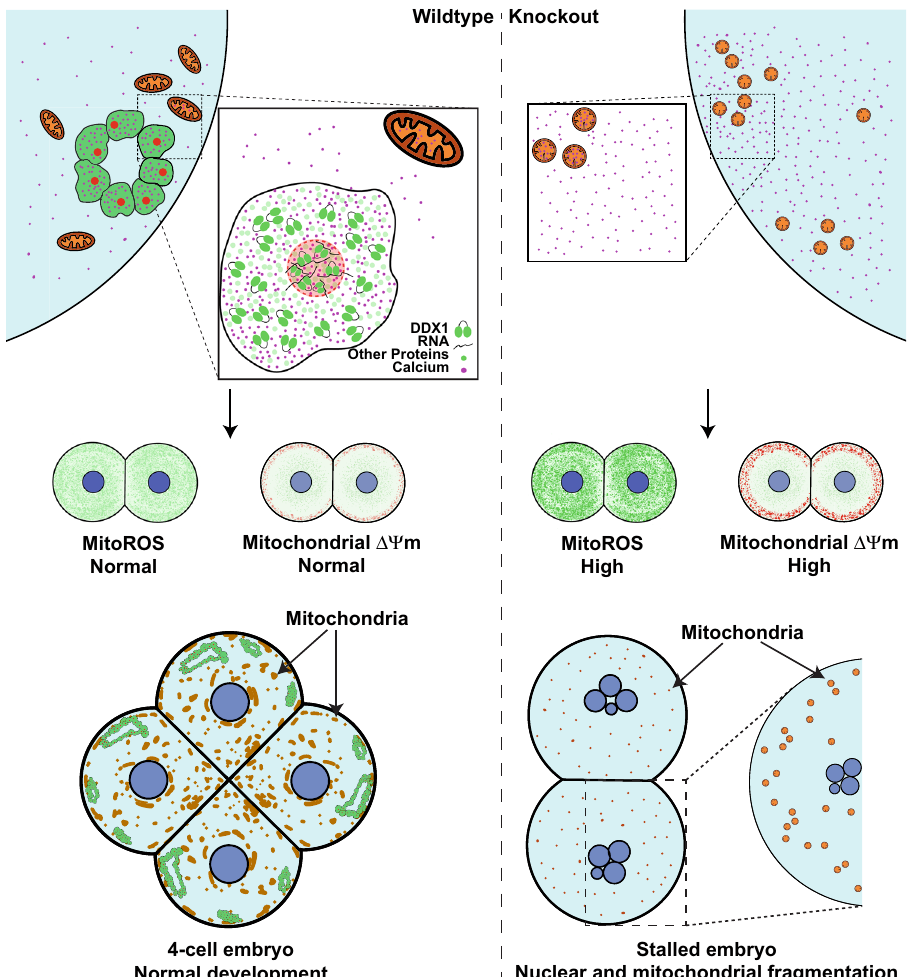
Fig. 7 Schematic depiction of DDX1 and MARV function. Wild-type embryos develop normally when MARVs are present. However, absence of MARVs in Ddx1 knockout embryos results in disrupted Ca 2 + distribution which causes upregulation of mitochondrial activity and increased mitochondrial ROS, leading to nuclear and mitochondrial